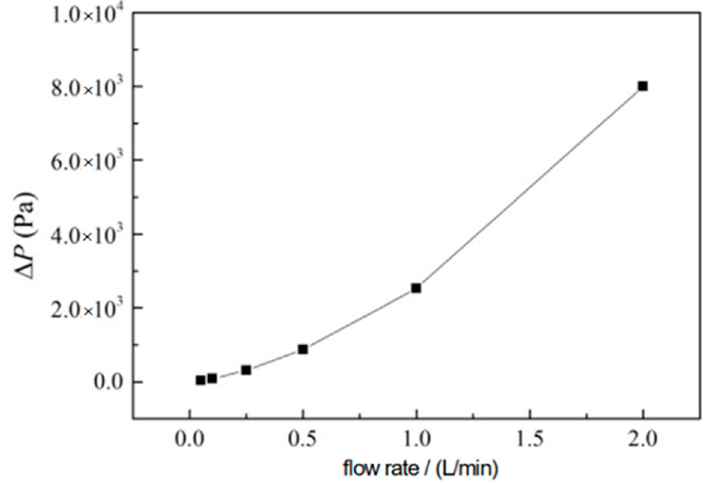
Figure 11. Effects of coolant flow rates on pressure drops (Pa) (from Gan et al. [41], with permission from Elsevier).